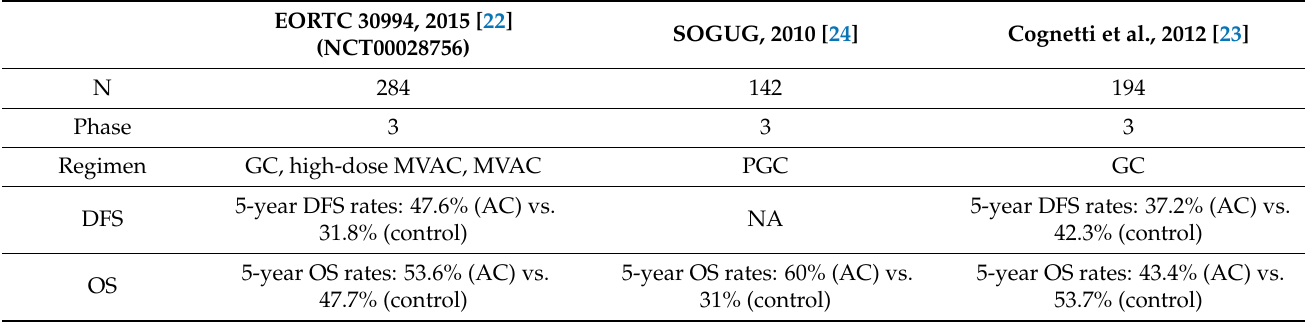
Table 2. Summary of trials for cisplatin-based adjuvant chemotherapy in muscle-invasive bladder